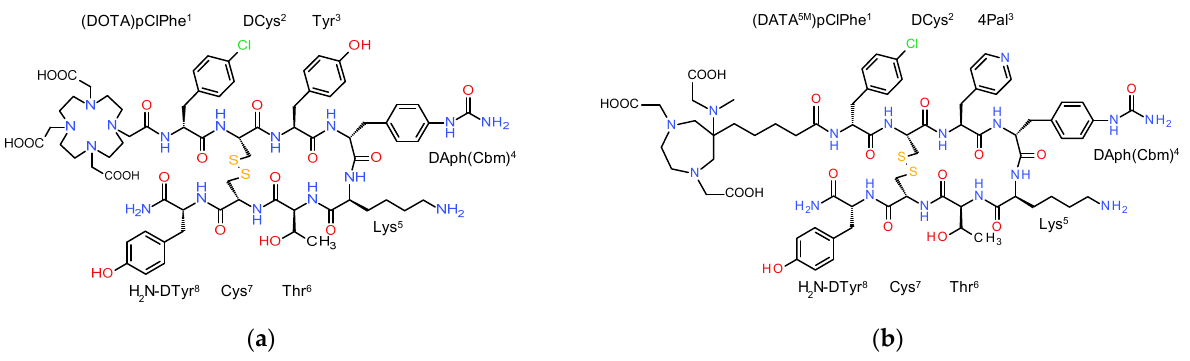
Figure 1. Chemical structures of ( a ) DOTA-LM3; ( b ) DATA 5m -LM4; the two analogs differ in the chelator and in the residue at position 3: Tyr (in LM3) and (4-pyridyl)alanine (4Pal, in LM4).